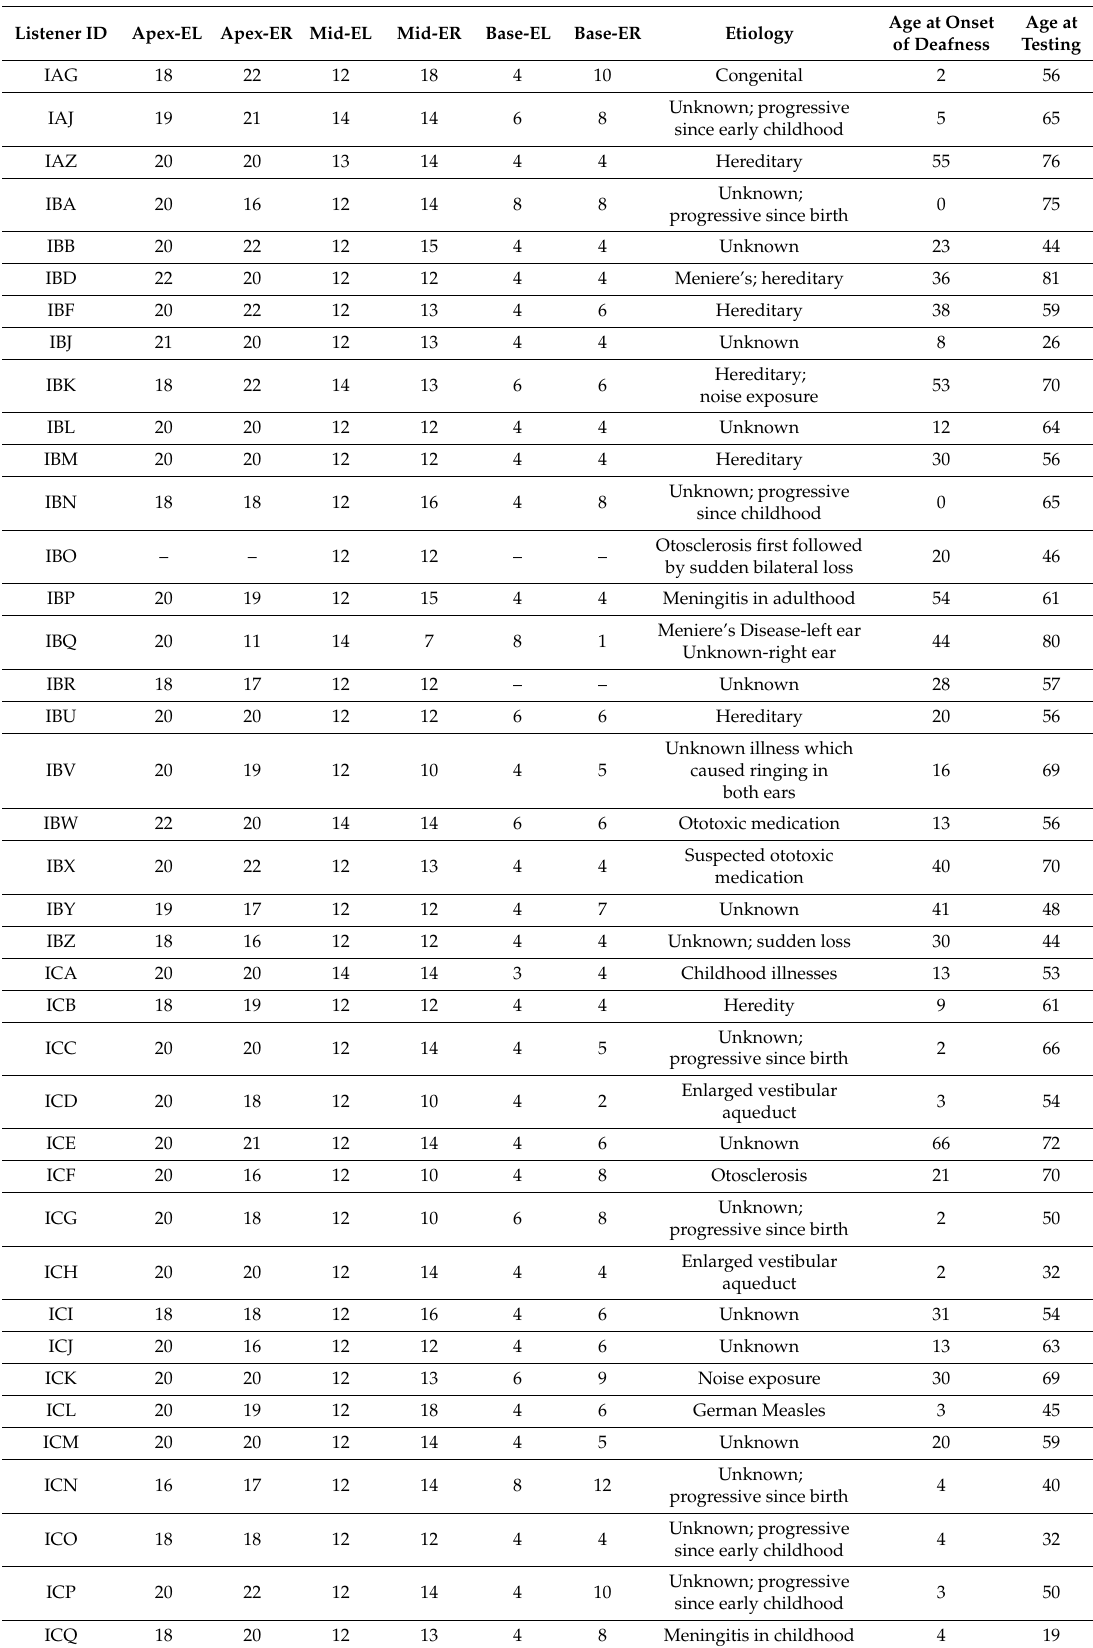
Table 1. Listener demographics and pitch-matched electrode